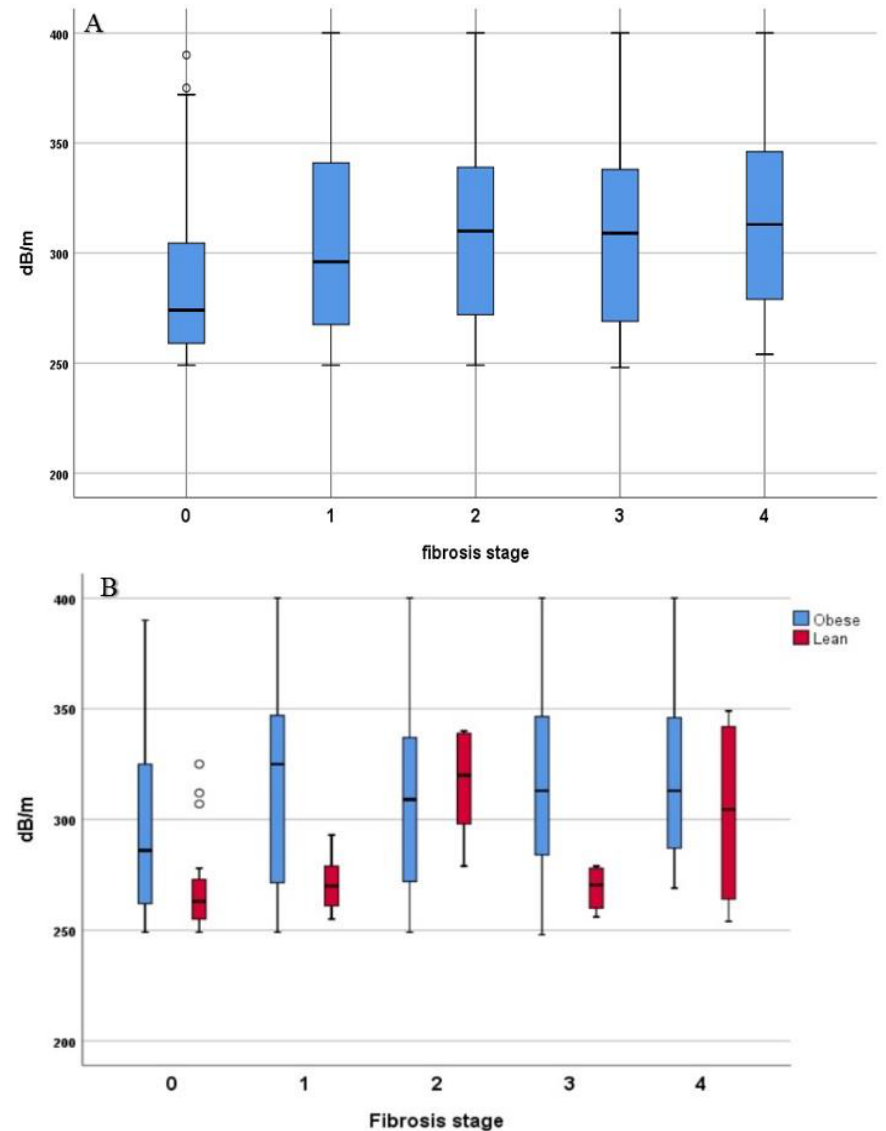
Figure 2. ( A ) Distribution of CAP values according to fibrosis stage; ( B ) distribution of CAP values among lean and obese patients according to fibrosis stage. Table 2. Parameters associated with the presence of fibrosis.